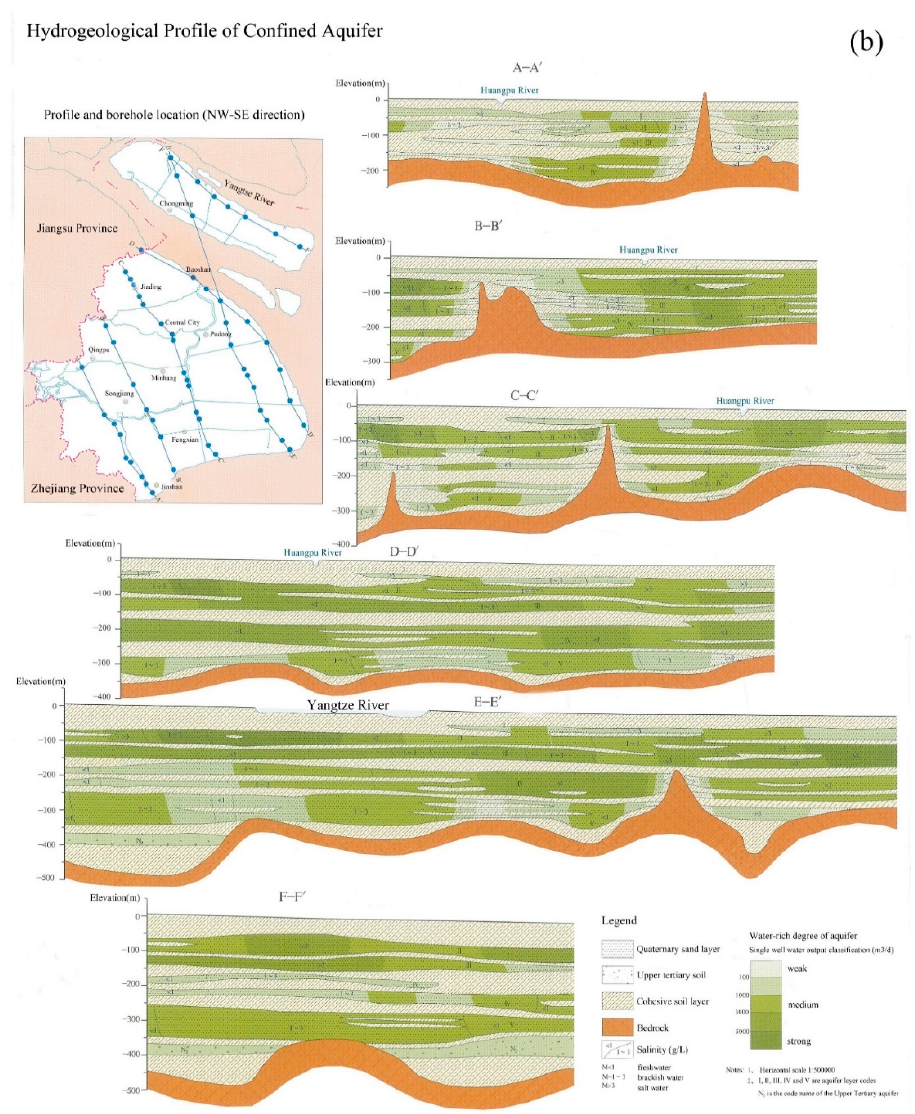
Figure 3. Hydrogeologic map and hydrogeological sections in Shanghai, China from Shanghai Geological Environment Atlas [39], ( a ) hydrogeologic map and two hydrogeological sections, ( b ) hydrogeological profile of confined aquifers